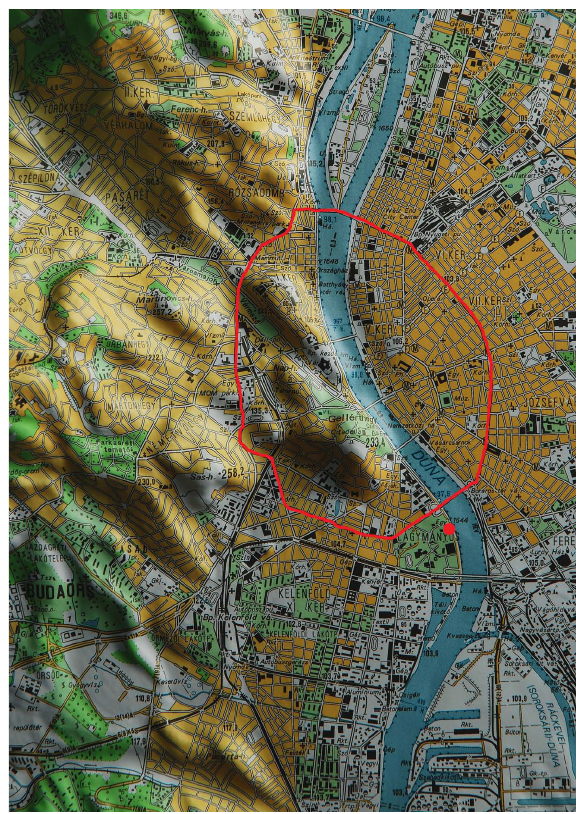
Fig. 1. Map of Budapest showing the central part of the city (indi- cated by red line) and the measurement location (marked by red dot) at the campus of the E¨otv¨os University downwind from the central urban part, on the bank of the river